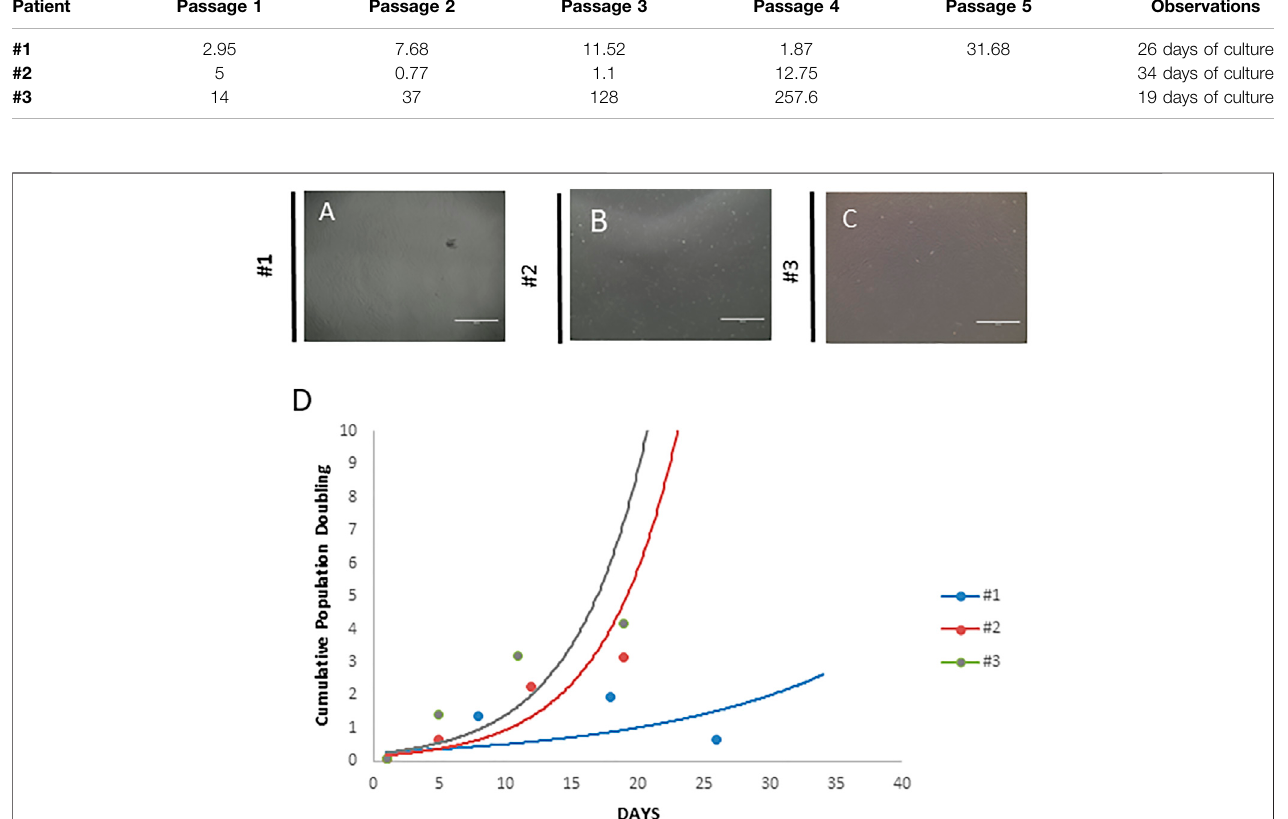
FIGURE2| Morphology ofthemesenchymalstemcell cultures. (A) Mesenchymal stemcellsfrom thepatient(senescence). Thecells show fi broblastmorphology, butinhigherpassages,thispatternseemstobelessevident,suggestingasenescencestate. (B) Mesenchymalstemcellsfromthehealthydonor.Thesecellsexhibiteda typical fi broblastoid morphology, and it is not lost even in high passages. (C) Mesenchymal stem cells from the patient (no senescence). These cells exhibited a typical fi broblastoidmorphology,anditisnotlosteveninhighpassages. (D) Cumulativecellpopulationdoubling.Bothcultureswereanalyzedusingthefollowingformula: log 10 (N/N 0 ) x 3.33, where N is the number of cells at the harvesting and N 0 is the number of cells plated. Scale bar = 1,000 µm.